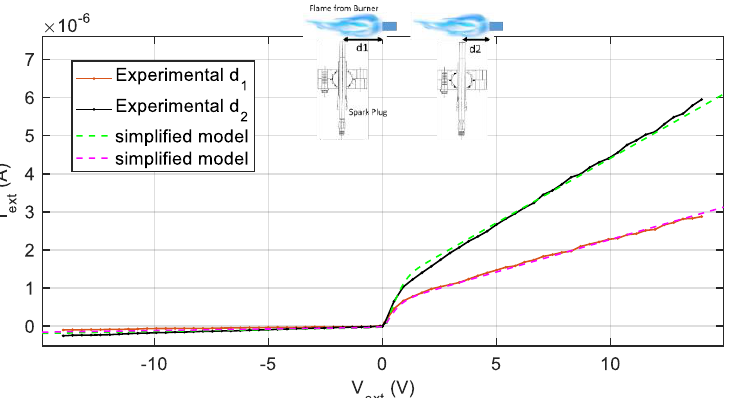
Figure 7. Experimental results (lines with markers) obtained placing the sensor (gas turbine spark plug) at two different distances from the torch nozzle ( d 1 = 6 cm, d 2 = 3 cm—picture right side). Dashed lines: model linearized at V W = 5 V.